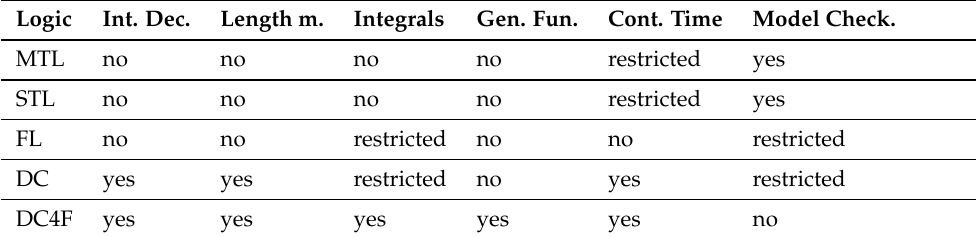
Table 1. Expressibility